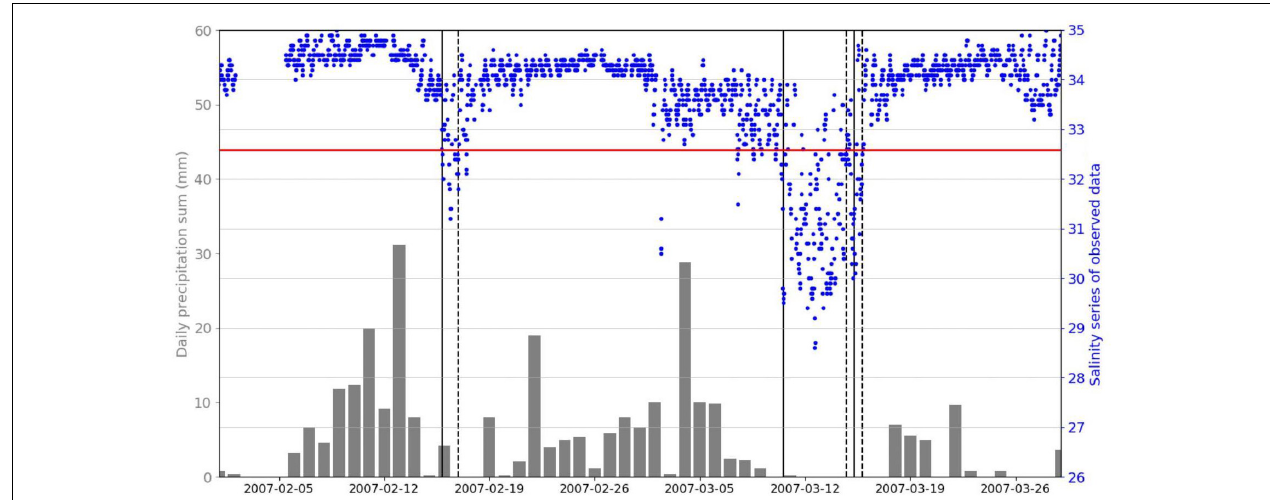
FIGURE 3 | Average daily precipitation (in mm, histograms in grey) and salinity at high and low tides (blue dots) for the period from 1st February 2007 to 29th March 2007. The red line indicates the 32.59 salinity threshold. The continuous and dashed black vertical lines show the beginning and the end of an extreme event,